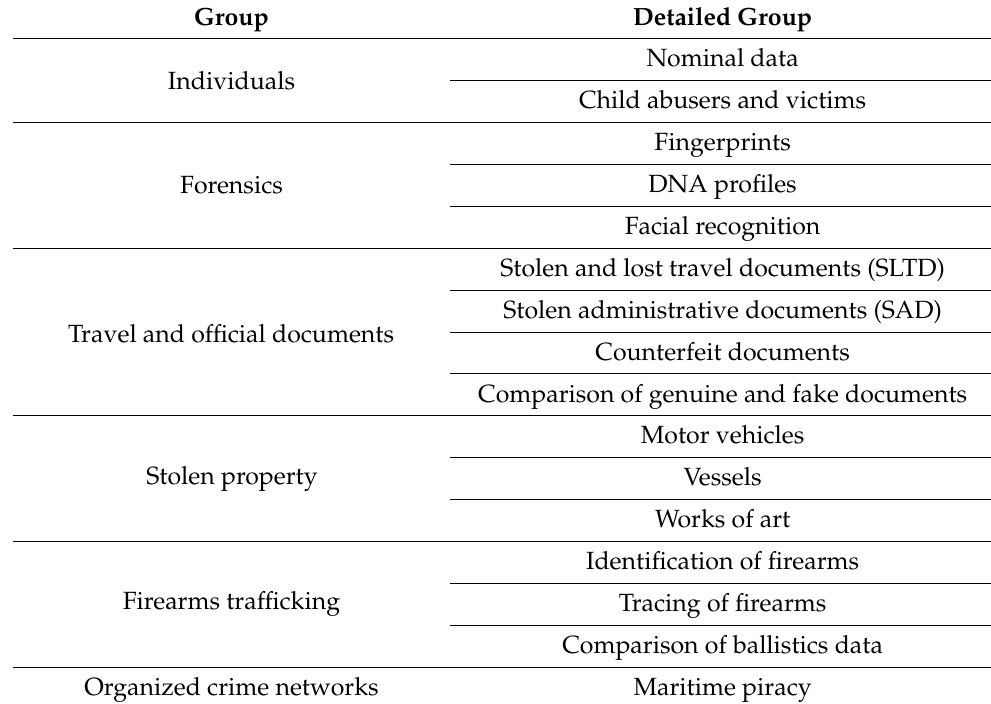
Table 1. List of Interpol’s crime